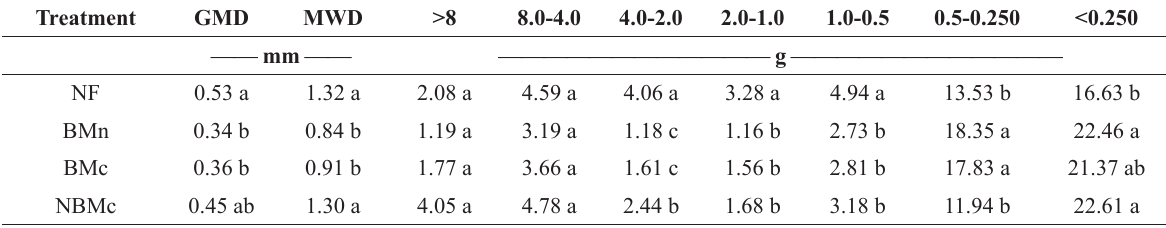
GMD: Geometric mean diameter. MWD: Mean weight diameter. Different letters in the column indicate significant differences in the Tukey test